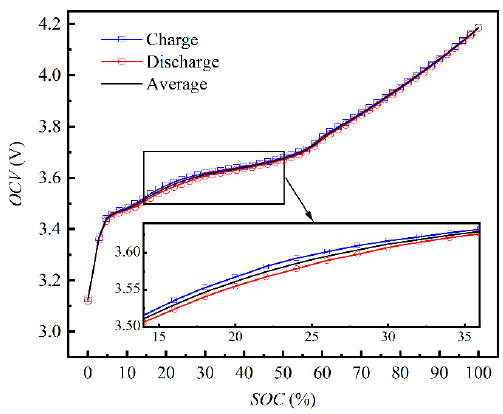
Figure 4. The SOC vs. OCV curves under the charge and discharge at 25 °C.